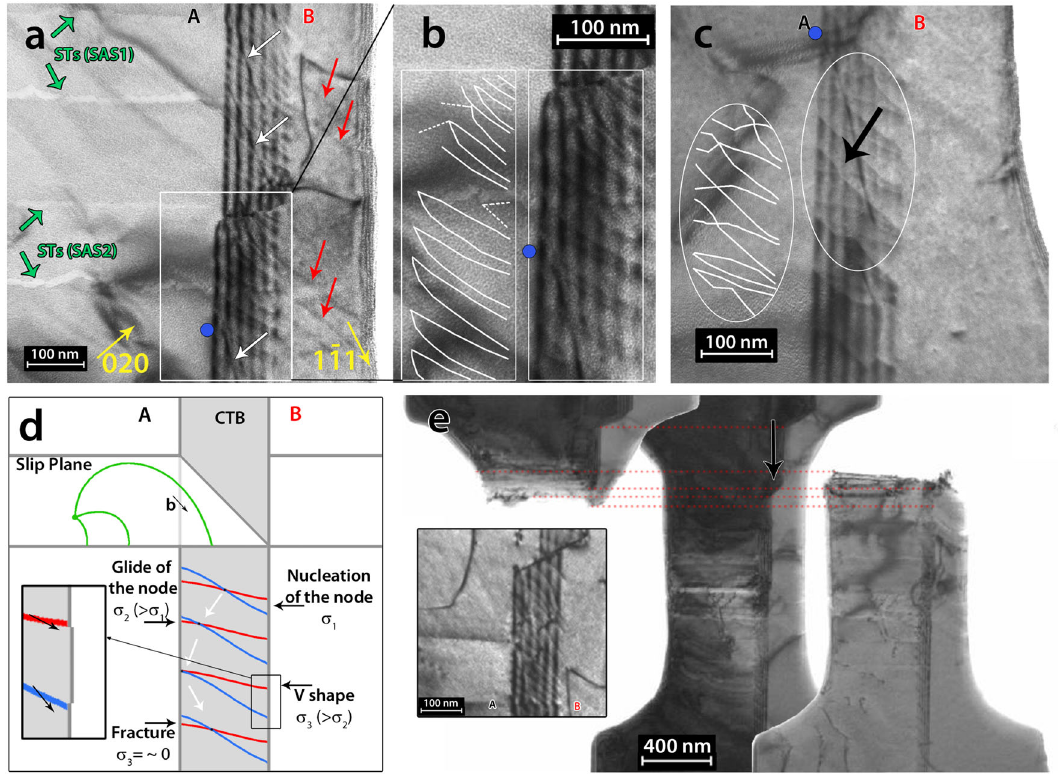
Fig. 3 Mechanism of absorption of screw dislocations at CTB. a and b Bright fi eld TEM micrograph after cycle 4 showing the arrangement of the twinning dislocations resulting from the absorption process of the incoming screw dislocations at the CTB. Green arrows indicate the position of STs from the single arm sources SAS1 and SAS2. Yellow arrows indicate the diffraction vectors while red arrows show the position of slip traces in grain B after transmission. White arrows indicate residual sessile dislocations left by annealing. White lines in b show the arrangement of the twinning dislocations in the white rectangle. c Bright fi eld TEM image obtained after fracture. The black arrow show the position of a constriction node. White lines show the arrangement of the twinning dislocations. d Schematic illustration of the mechanism controlling the absorption process of the incoming curved screw dislocations (green lines): it involves the nucleation and the glide of constriction nodes in the same direction at the CTB plane as well as the backward motion of the nodes by relaxation of internal stress in the CTB after fracture. The two TDs of Eq. (1) form a pair of up-down single atomic steps; see the red and blue lines inside the black rectangle. e BF-TEM image showing the fracture at the CTB ledge indicated by a black arrow. The inset shows the accumulation of twinning dislocations (resulting from the absorption process) at the CTB